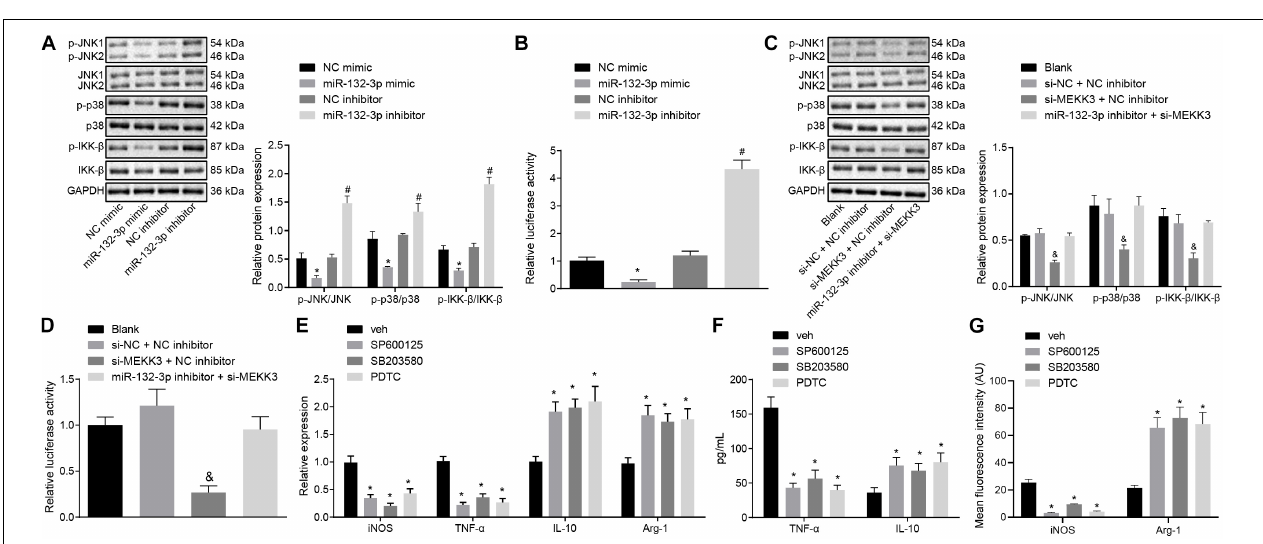
FIGURE 5 | miR-132-3p upregulation hinders M1 polarization of macrophage from SCIR injury rats by inactivating the NF- κ B and p38/JNK signaling pathways via MEKK3 downregulation. (A) Protein expression of JNK, p38, and IKK- β as well as the extent of JNK, p38, and IKK- β phosphorylation measured by Western blot analysis in macrophages transfected with miR-132-3p mimic or miR-132-3p inhibitor. (B) NF- κ B luciferase activity detected by dual-luciferase reporter gene assay in macrophages transfected with miR-132-3p mimic or miR-132-3p inhibitor. (C) Protein expression of JNK, p38, and IKK- β as well as the extent of JNK, p38, and IKK- β phosphorylation measured by western blot analysis in macrophages transfected with si-MEKK3 or in combination with miR-132-3p inhibitor. (D) NF- κ B luciferase activity detected by dual-luciferase reporter gene assay in macrophages transfected with si-MEKK3 or in combination with miR-132-3p inhibitor. * p < 0.05 vs. macrophages transfected with NC mimic. # p < 0.05 vs. macrophages transfected with NC inhibitor. & p < 0.05 vs. macrophages transfected with both si-NC and NC inhibitor. (E) Expression of inflammatory factors iNOS, TNF- α , IL-10, and Arg-1 in macrophages after treatment with SP600125, SB203580, or PDTC detected by RT-qPCR. (F) The level of TNF- α and IL-10 in macrophages after treatment with SP600125, SB203580, or PDTC measured by ELISA. * p < 0.05 vs. macrophages treated with DMSO. (G) Expression of iNOS and Arg-1 in macrophages after treatment with SP600125, SB203580, or PDTC detected by immunofluorescence staining. * p < 0.05 vs. macrophages treated with DMSO. Measurement data were expressed as mean ± standard deviation. Differences between two groups were compared by unpaired t -test. Comparisons of data among multiple groups were conducted by one-way ANOVA. The experiment was repeated three times